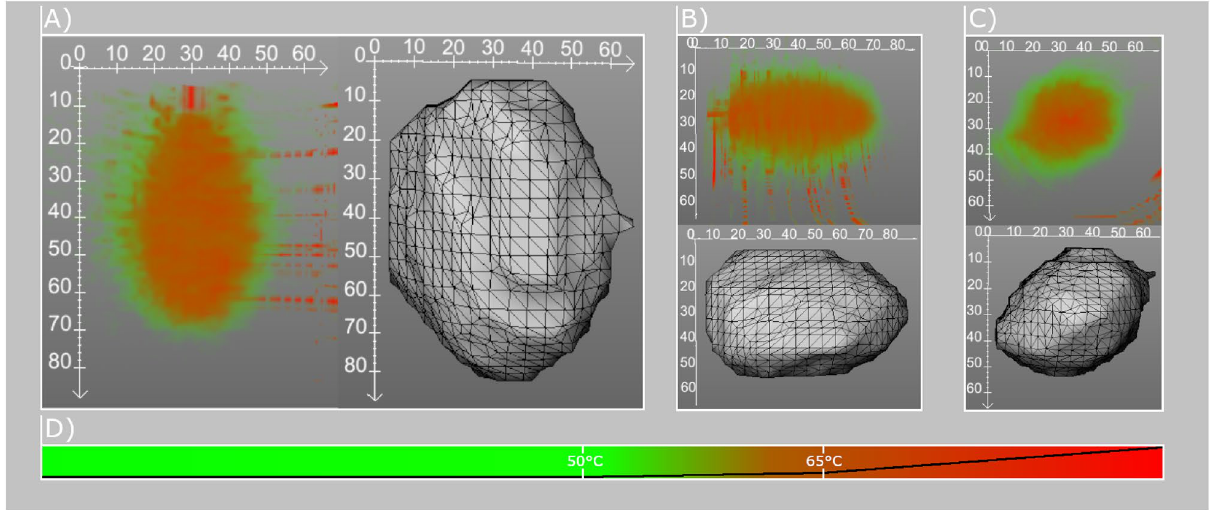
Figure 1. Reconstruction results for the temperature interpolation and the Delaunay triangulation in axial ( A ), sagittal ( B ) and coronal ( C ). ( D ) shows the color bar used for the temperature interpolation visualization (0 ◦ C–100 C). The black line indicates the alpha value of the